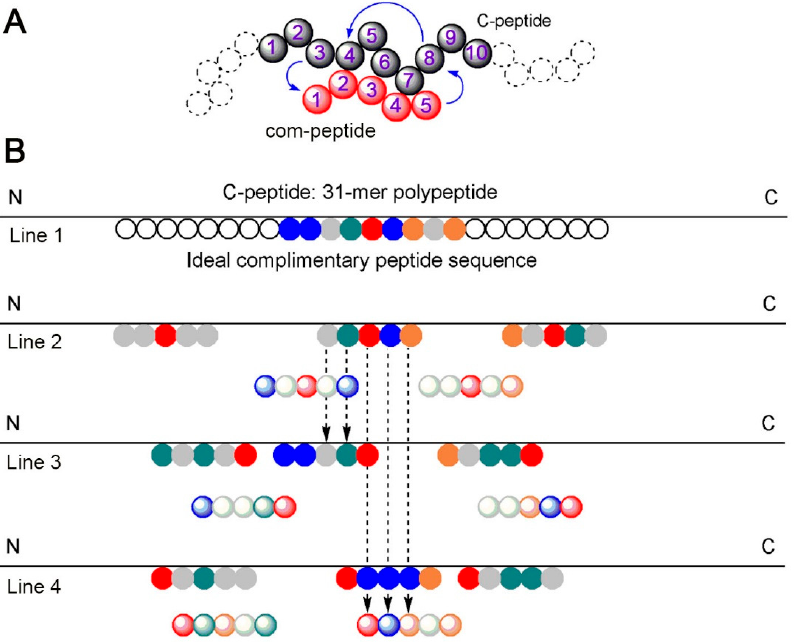
Figure 1. The various coloured circles represent different amino acid residues. The dotted arrows point to the segments of pentapeptide sequences that can be picked up a focussed library possessing those segments. ( A ) Illustration of how inter-peptide interaction is also affected by intra-peptide residue interaction. In this example, residue 3 of C-peptide may interact favourably with residue 1 of the com-peptide. This would affect how residues 2–5 of the com-peptide interact with residues 4–8 of the C-peptide. ( B ) Illustration of the triple-overlay strategy for the search of a complementary peptide (com-peptide) to co-assemble with C-peptide. The pentapeptide in Line 2 can pick up two further pentapeptide sequences in Lines 3 and 4 via the consensus triplet sectors.